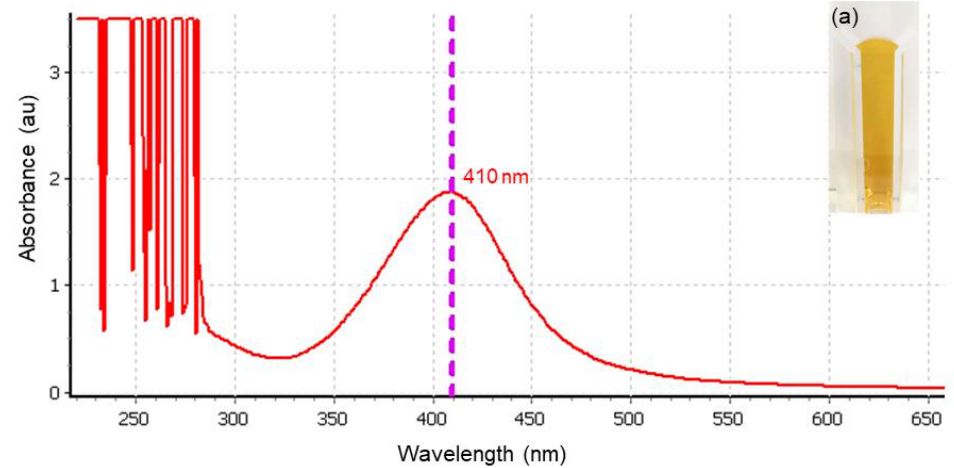
Figure 1. UV-Vis spectra of silver nanoparticles at 410 nm; inset ( a ): TA-AgNPs colloid showed a yellow color.